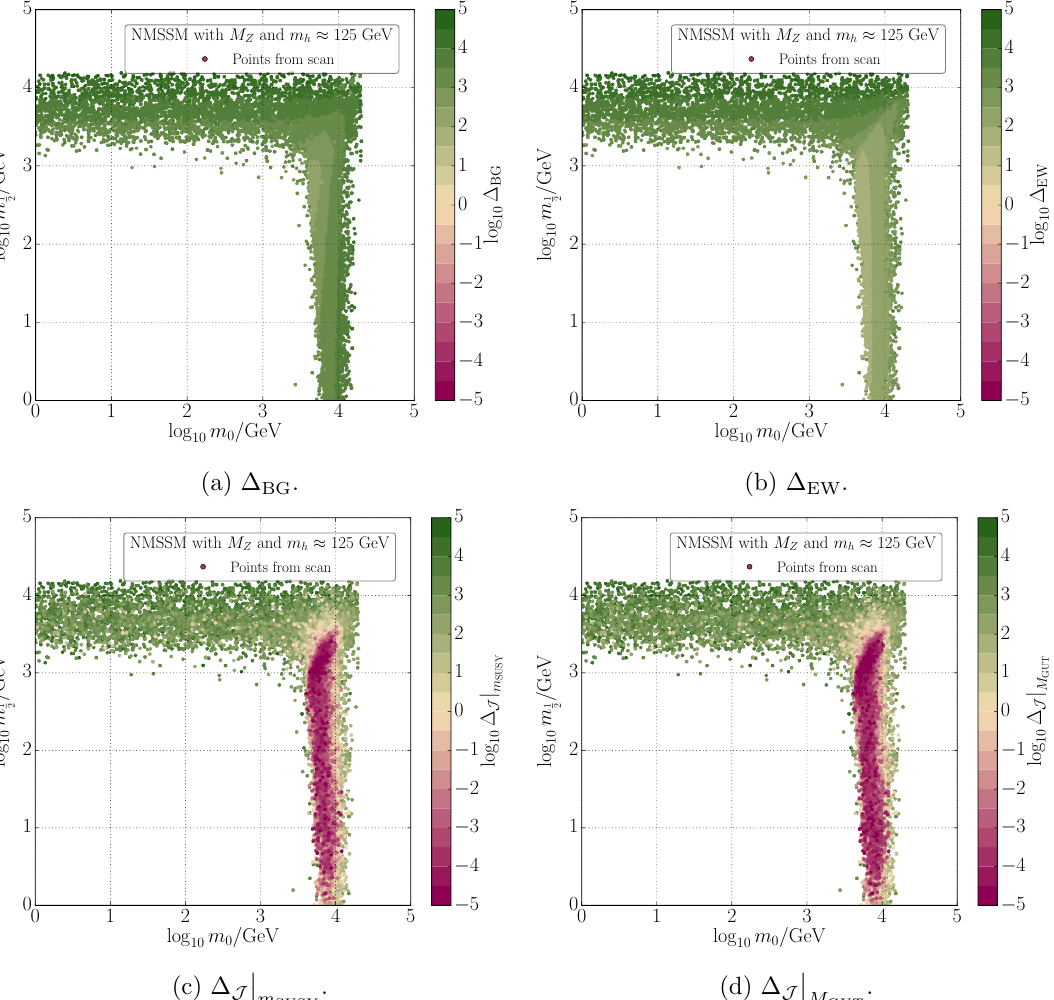
Figure 10. Comparison of (cid:12)ne-tuning measures in the NMSSM with m h m ) plane. For their de(cid:12)nitions, see section 1 = 2